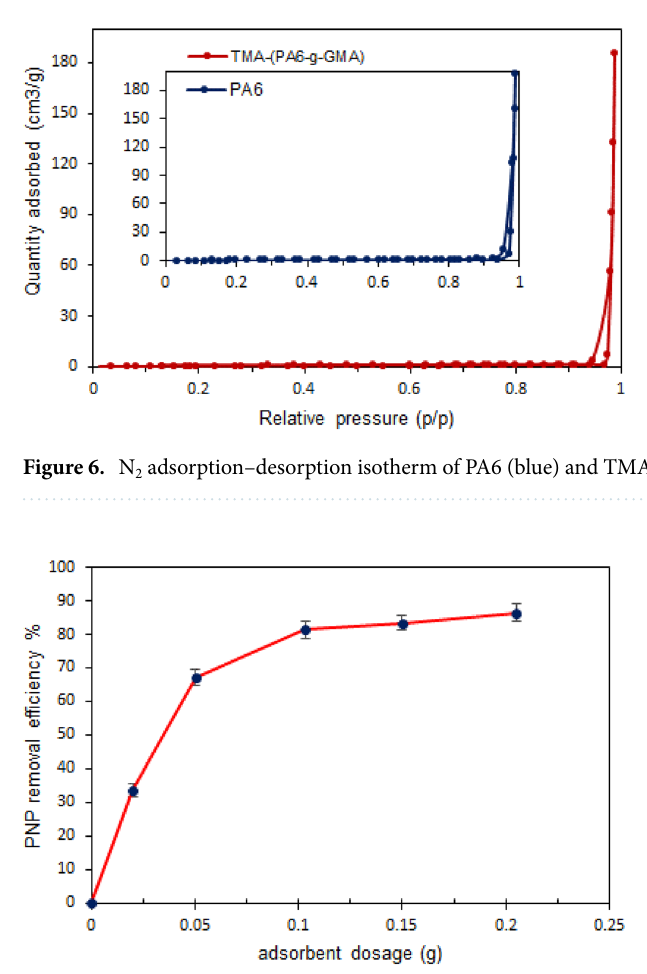
Figure 7. Effect of adsorbent dosage to the PNP removal efficiency (PNP initial concentration: 50 mg/L; time: 1 h; temperature 298 K and 150